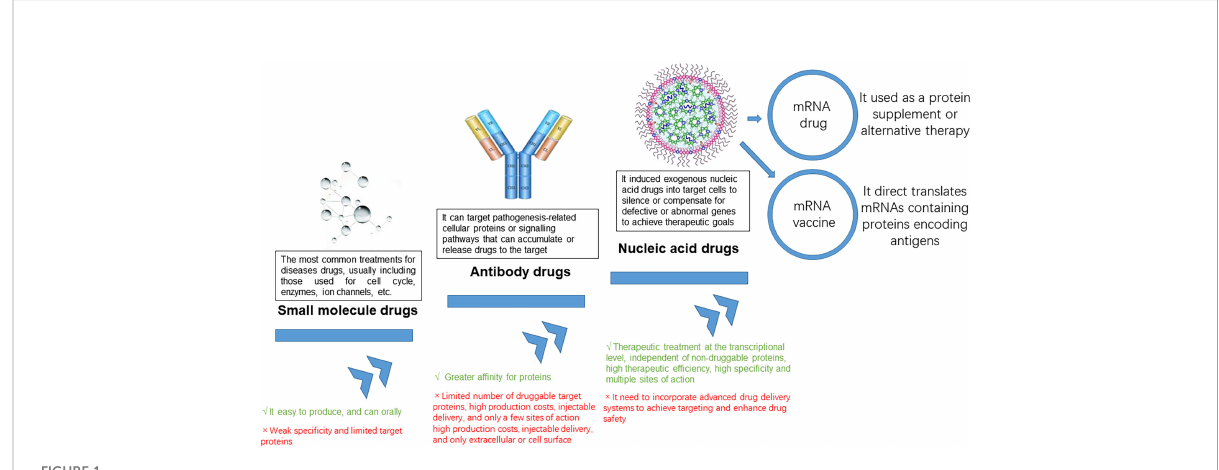
FIGURE 1 Trends in the evolution of therapeutic